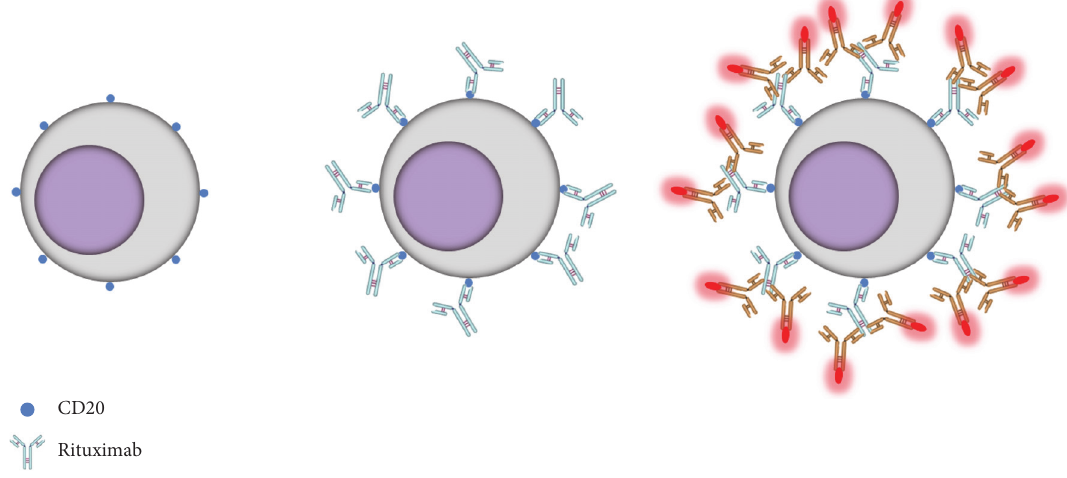
steroid medication (1 mg/kg equivalent of decortin) did